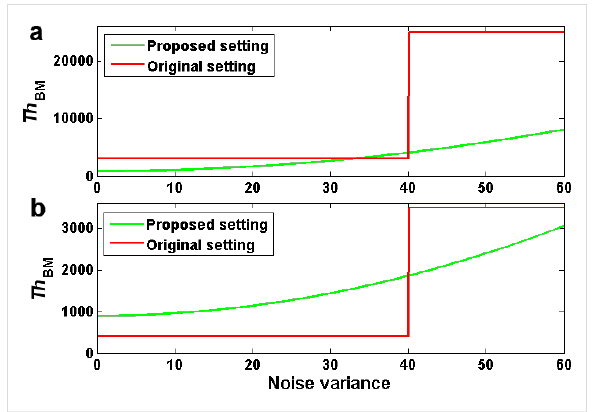
Figure 4: Parameterization of the block-matching: a) at the first level, b) at the second level.